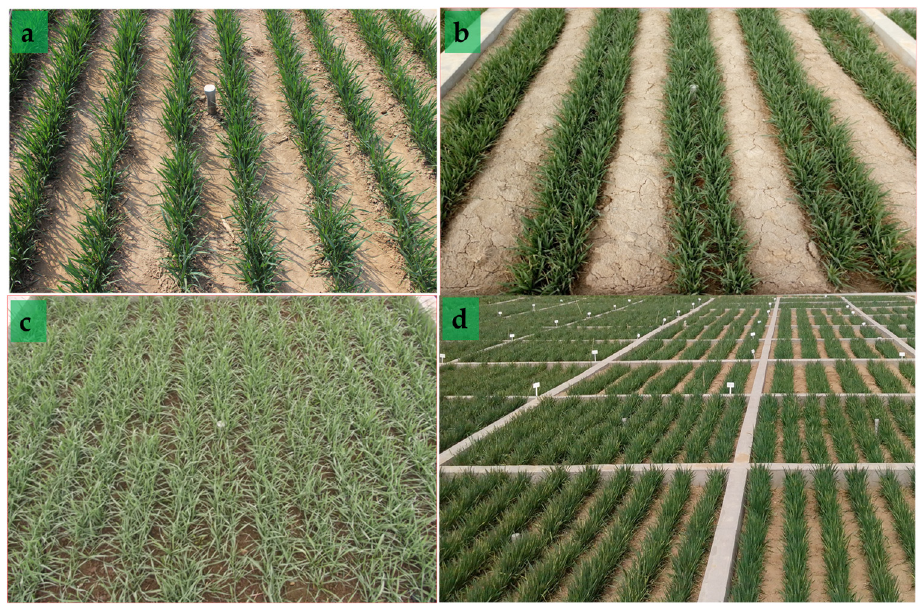
Figure 3. Field pictures of uniform row ( a ), furrow-ridge row ( b ), double-double row ( c ), and whole plots of concrete plot structure ( d ).